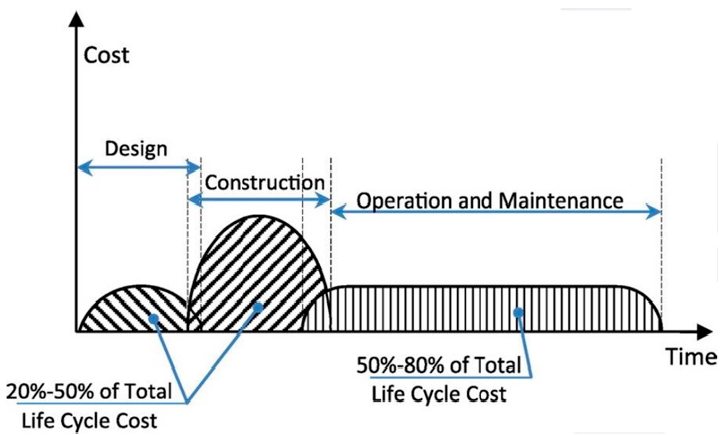
Figure 7. Life Cycle Cost [8].